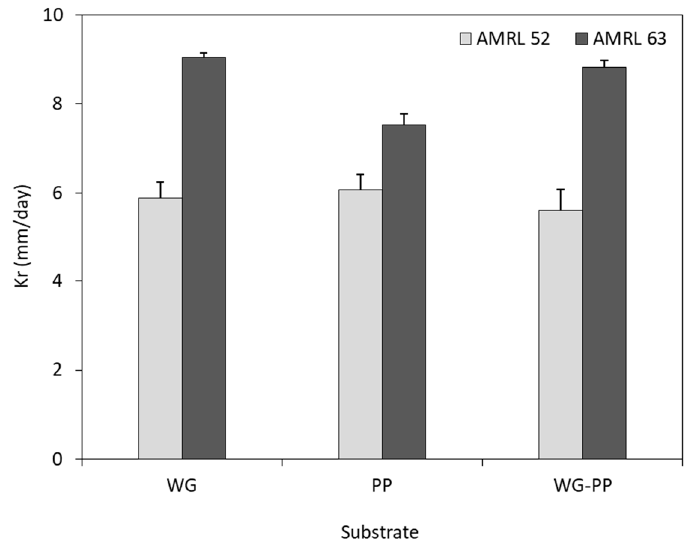
Figure 3. Growth rate of yellow (AMRL 52) and black (AMRL 63) morel strains during solid-state fermentation on wheat grains (WG), potato peels (PP), and a mixture of them (WG–PP, 1:1).